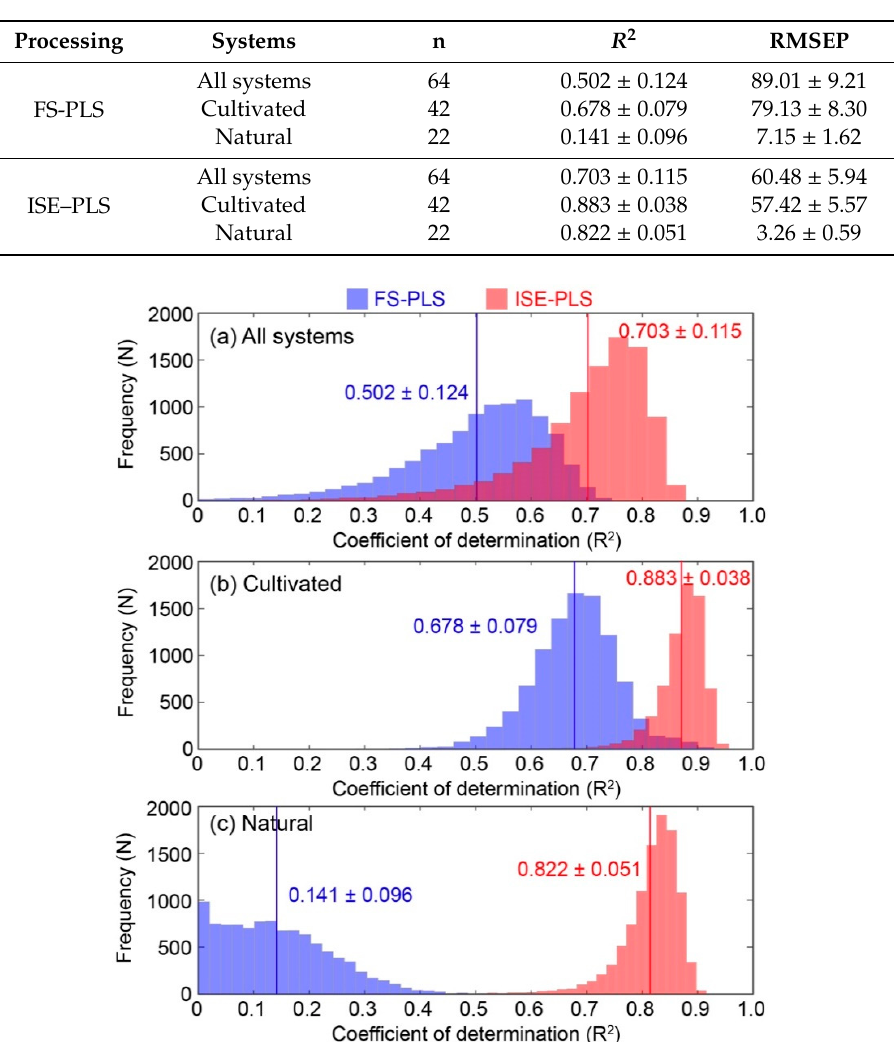
Table 6. Mean and standard deviation (SD) values of R 2 and RMSEP from N = 10,000 evaluations with FS-PLS and ISE–PLS in test data sets (30%).